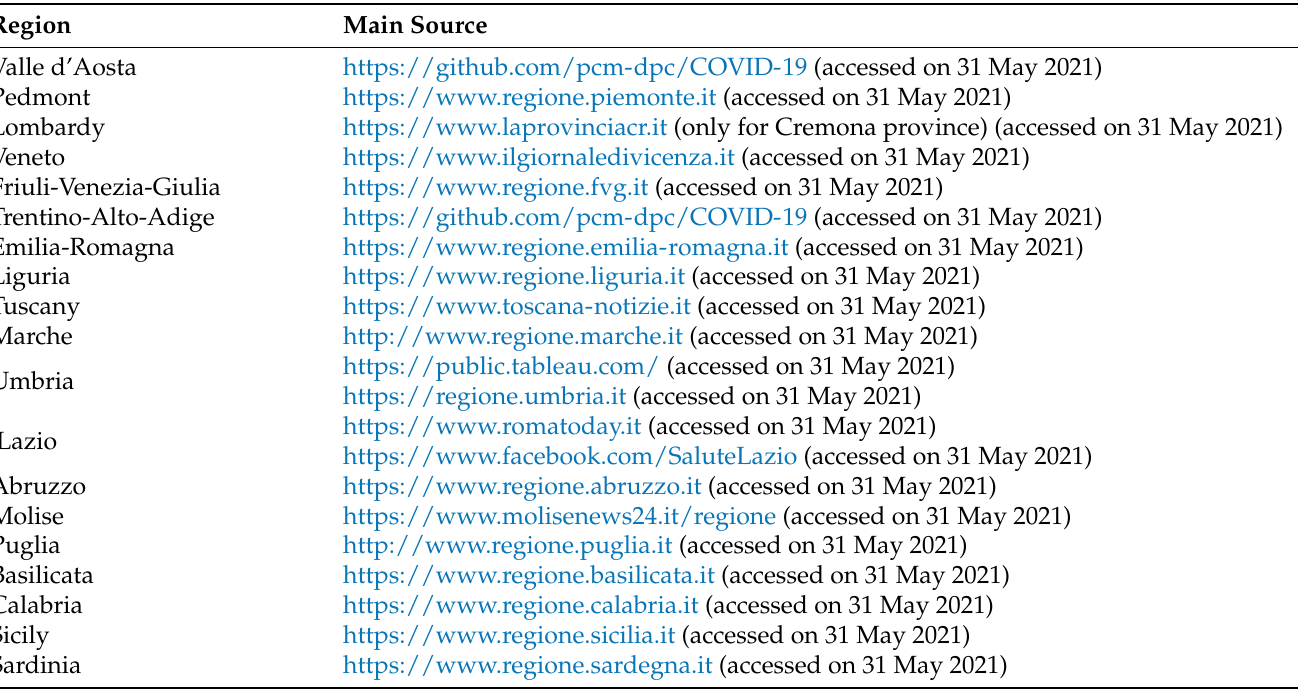
Table 1. Main data sources for provincial COVID-19